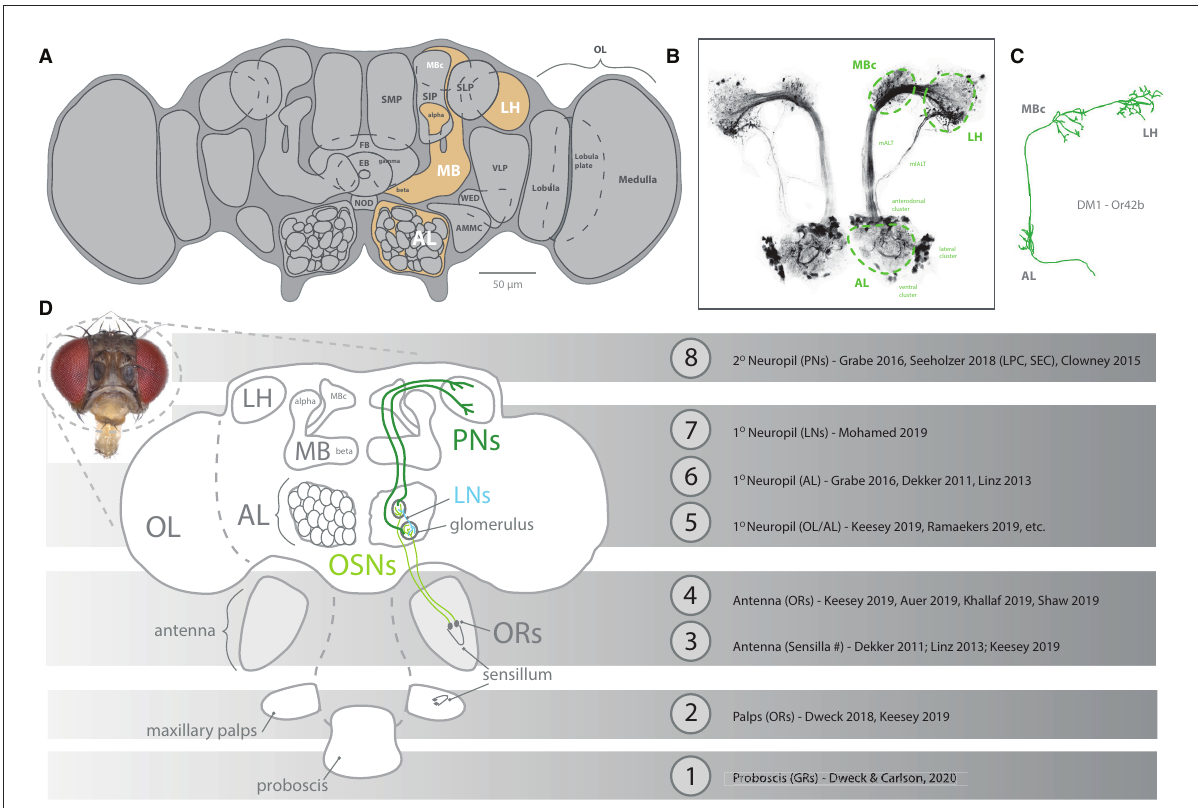
FIGURE2 An overview diagram of chemosensation. (A) The brain of Drosophila melanogaster , identifying neuropils related to olfaction (orange). Primary processing occurs in the AL (using glomeruli), with subsequent secondary processing in high brain regions, such as MB and LH. (B) Neural staining of AL and tracts toward both MB and LH, including clusters of cell bodies for projection neurons. (C) Reconstruction of a single projection neuron pathway from AL to high brain centers. (D) Schematic of pathways from peripheral olfactory organs, such as antenna and maxillary palps, where sensillum expresses olfactory receptors (ORs) within olfactory sensory neurons (OSNs). These peripheral OSNs first connect to a glomerulus within the AL before projection neurons (PNs) carry this signal onto the MB and LH. A multitude of papers have provided robust description and assessment of each stage (#1-8) of olfaction and gustation. AL, antennal lobe; OL, optic lobe; MB, mushroom body; LH, lateral horn; LN, lateral interneurons; PN, projection neurons; OR, olfactory receptor; OSN, olfactory sensory